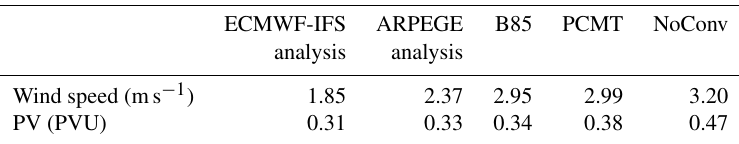
Figure 2. Vertical cross-section at 58 ◦ N (grey line in Fig. 1) of the zonal wind (shadings) and potential vorticity (black contours with hatched areas for values superior to 2PVU, bold contour for 0PVU) at 15:00UTC, 2 October 2016 for (a) ECMWF-IFS analysis, (b) ARPEGE anal- ysis, (c) ERA reanalysis, (d) simulation with B85, (e) simulation with PCMT and (f) simulation without deep convection parameterisation. The thick crosses represent the location of wind speed maxima. Table 1. Root mean square of the difference with ERA5 reanalysis of the ECMWF-IFS and ARPEGE analyses and the three forecasts in PV and wind speed at 600hPa over the domain shown in Fig.